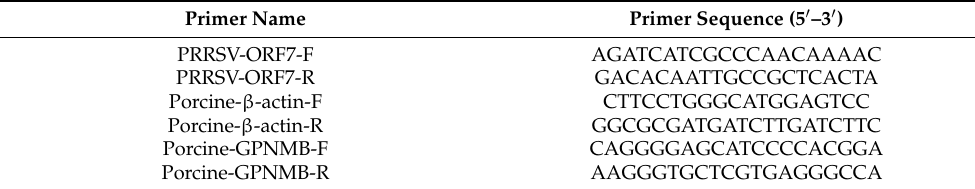
Table 3. Primers used for relative quantitative